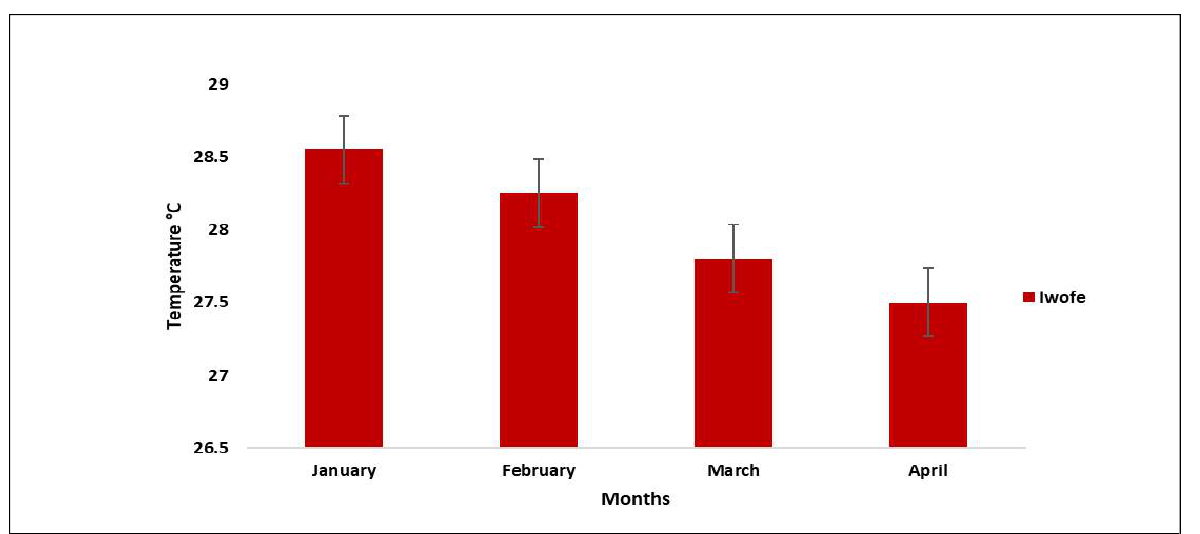
Figure 4: Total Dissolved Solid levels of Iwofe River